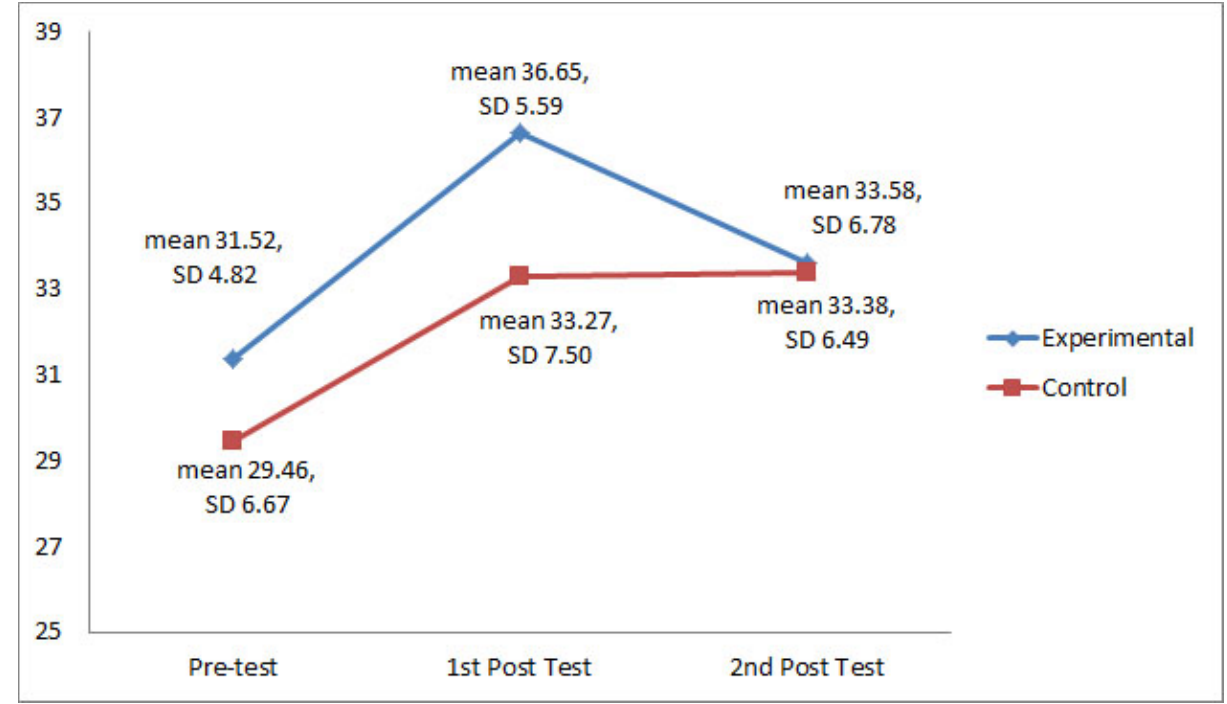
Figure 4. Performance mean scores and standard deviation at pretest, first posttest, and second